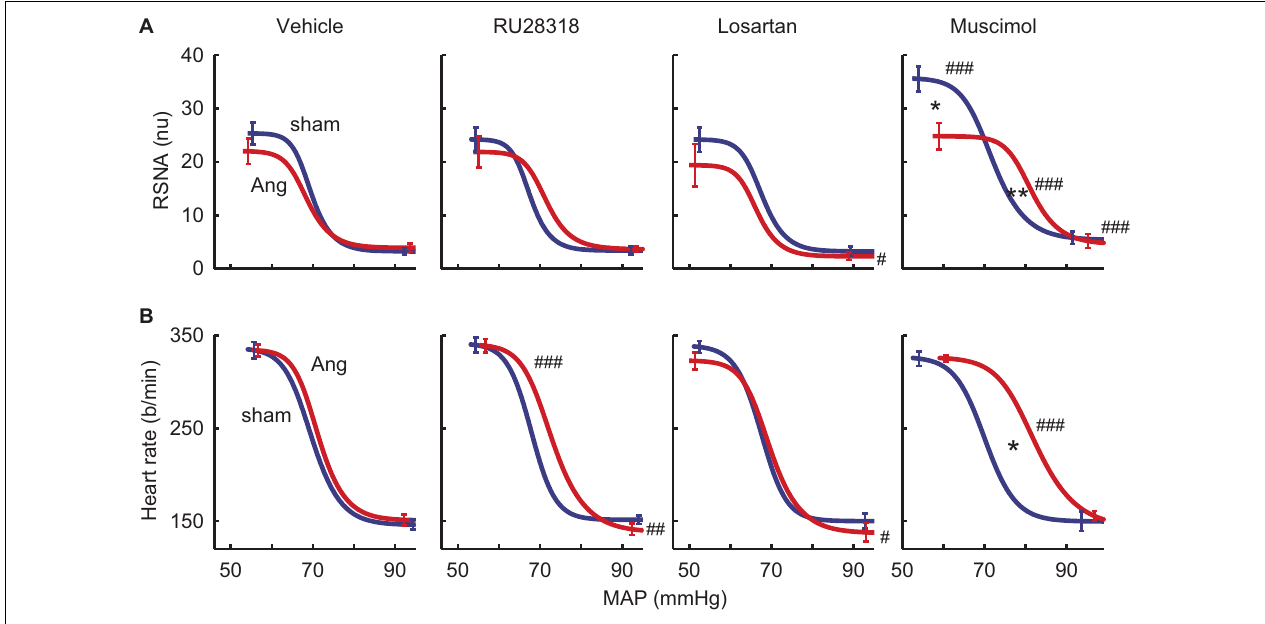
FIGURE 8 | Effects of antagonists and agonist on baroreflexes. (A) MAP-renal sympathetic nerve activity (RSNA, normalized units) relationships after bilateral microinjection in the PVN of vehicle ( n = 7–10), RU28318 ( n = 7–10), losartan ( n = 5–7), and muscimol ( n = 4–6) in sham (blue) and Ang II (red) treated rabbits. (B) MAP-heart rate curves. Data are mean ± SEM. Family wise error rate was controlled using a modified Bonferroni procedure. * P < 0.05 and ** P < 0.001 for Ang II vs sham; # P < 0.05, ## P < 0.01, and ### P < 0.001 for antagonist or agonist vs vehicle.